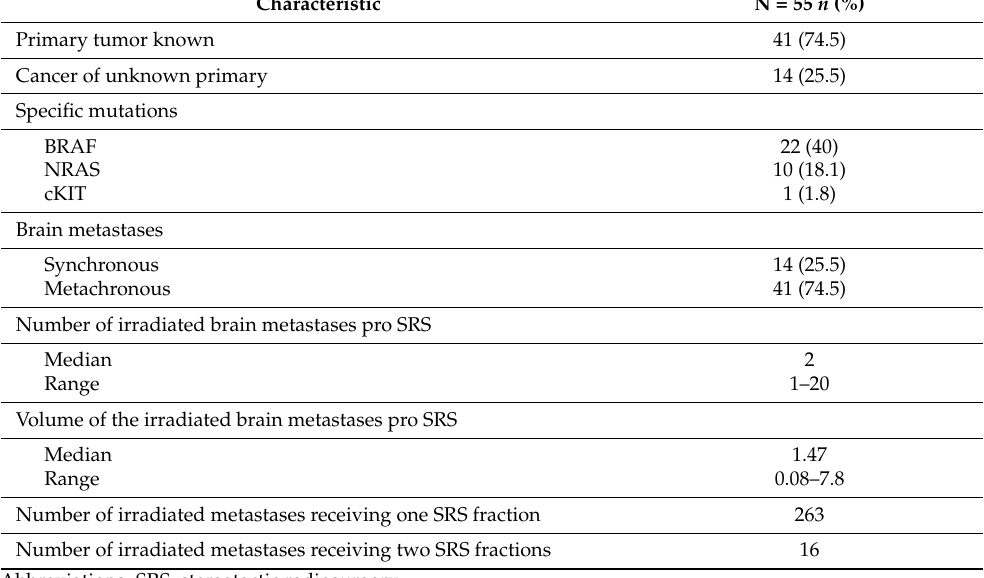
Table 1. Tumor characteristics.